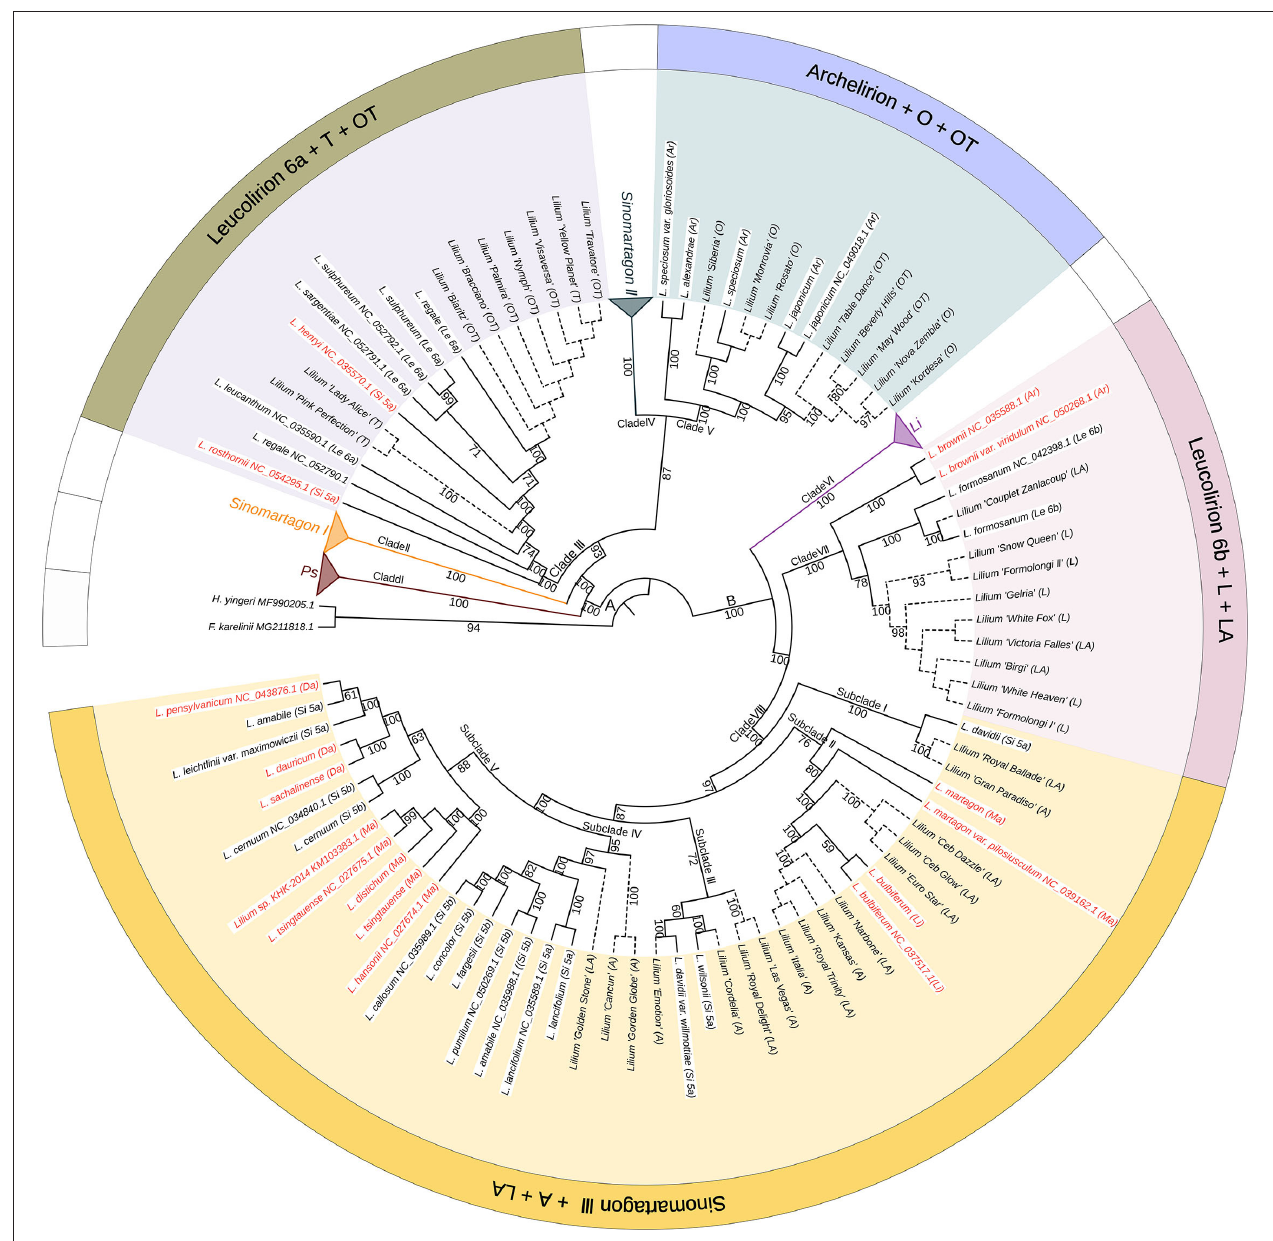
FIGURE 4 | The phylogenetic relationships between wild species and cultivars in Lilium using plastomes based on the maximum likelihood method. Numbers associated with the branches are bootstrap values. A and B indicate the two major groups distinguished based on all three phylogenetic reconstruction methods. Clades I, II, III, IV, V, VI, VII, and VIII indicate the major clades of Lilium species. Terminal names comprise wild species and cultivars. Species that conform to Comber’s classification are shown in black color and those inconsistent placements are shown in red color. Solid lines represent wild species, while dotted lines represent cultivars. Ps, Pseudolirium ; Le, Leucolirion ; Li, Lilium ; Ar, Archelirion ; Si, Sinomartagon ; Ma, Martagon ; Da, Dautolirion ; A, Asiatic hybrids; O, Oriental hybrids; L, Longiflorum hybrids; T, Trumpet hybrids; OT, Oriental-Trumpet hybrids; LA, Longiflorum-Asiatic hybrids.